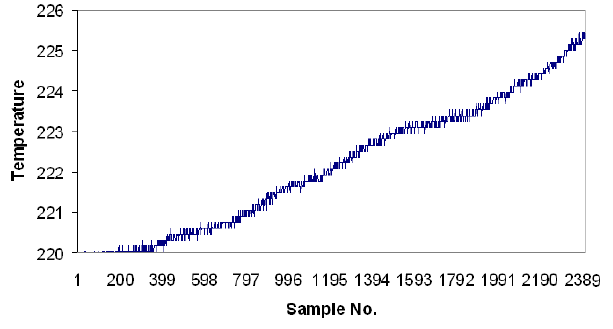
Figure 4. CSA temperature profile for increasing power. Table 1. Reactor temperature and temperature fluctuations as a function of the reactor